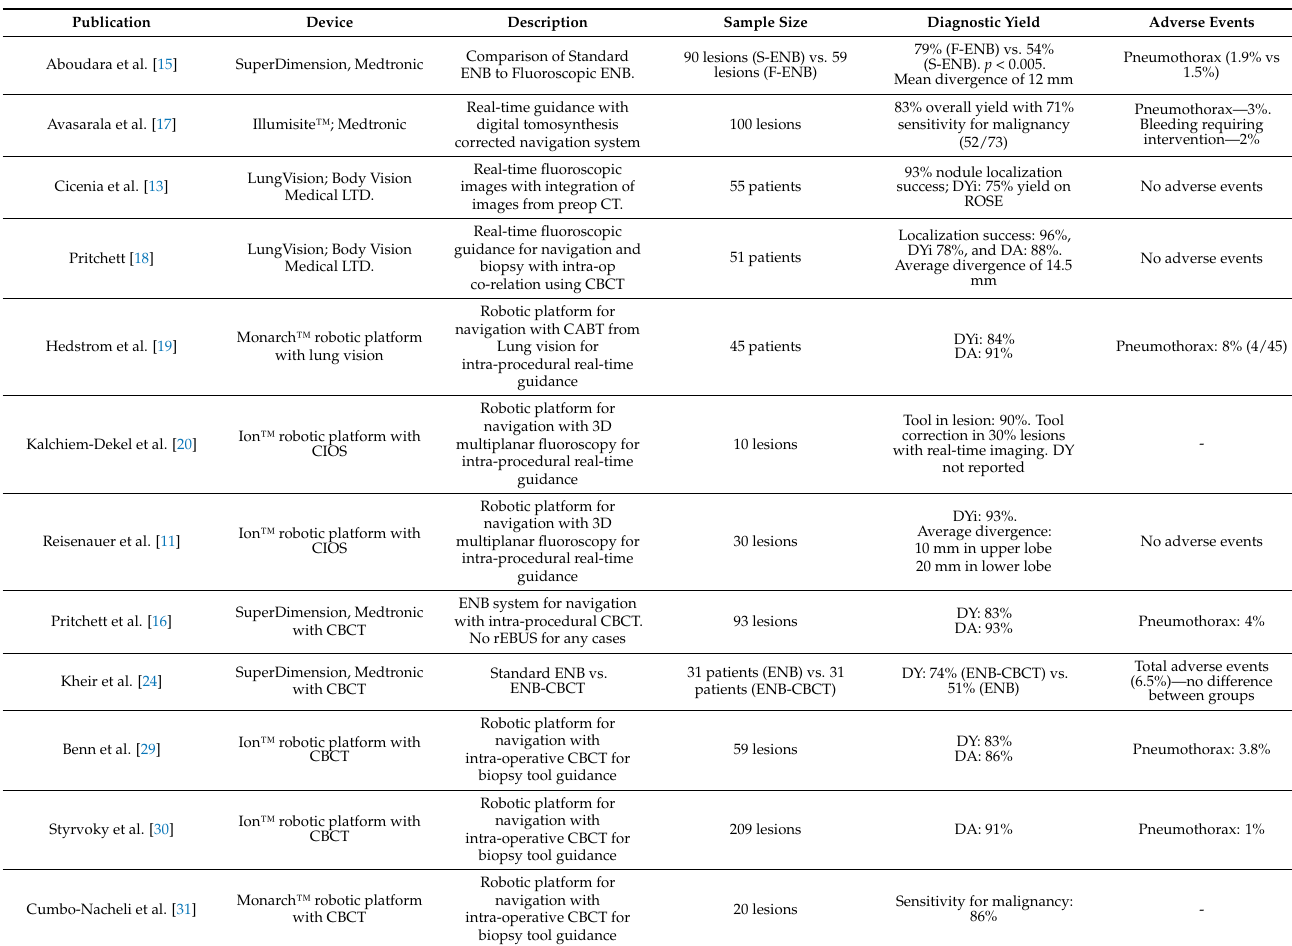
Table 1. Description of studies utilizing additional imaging with robotic bronchoscopy and electro- magnetic navigation